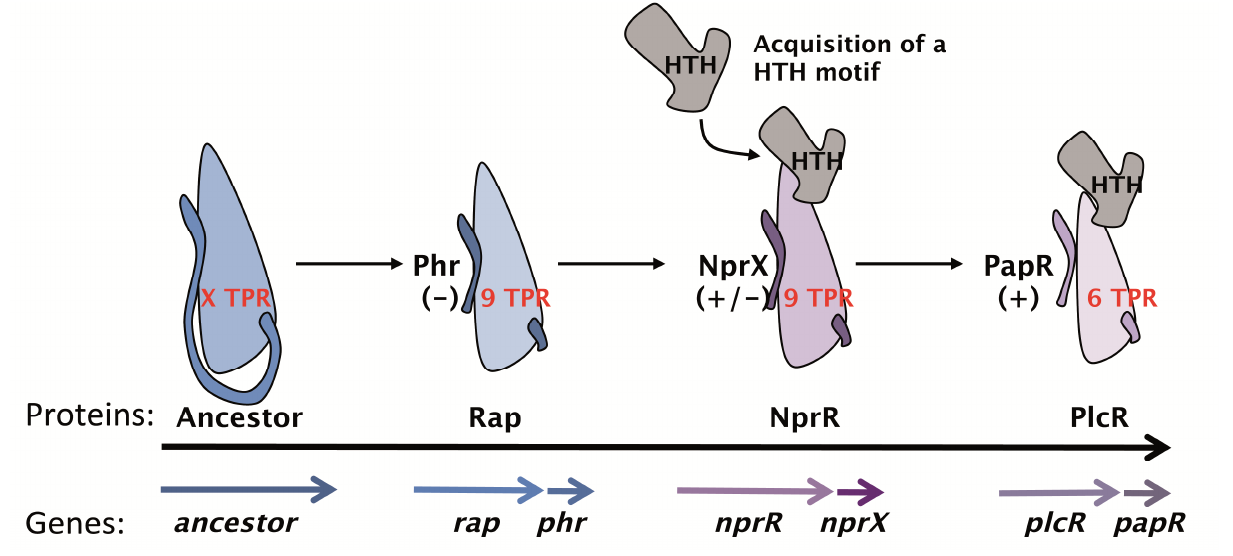
FIGURE 1: Evolution of the RNPP family in Bacilli . The presumed ancestor protein contains X TPR motifs and an inhibitor C- terminal end. The first step of this evolution scheme is the separation of the ancestral gene in two separate genes encoding, from 5’ to 3’, the quorum sensor (Rap) and an inhibitor signaling peptide (Phr). The second step is the acquisition of an HTH domain resulting in a bifunctional protein (NprR) controlled by a molecular switch (NprX) having an inhibitory (-) or activating (+) effect. The third step is the loss of 3 TPR motifs and leads to the PlcR-PapR quorum sensing